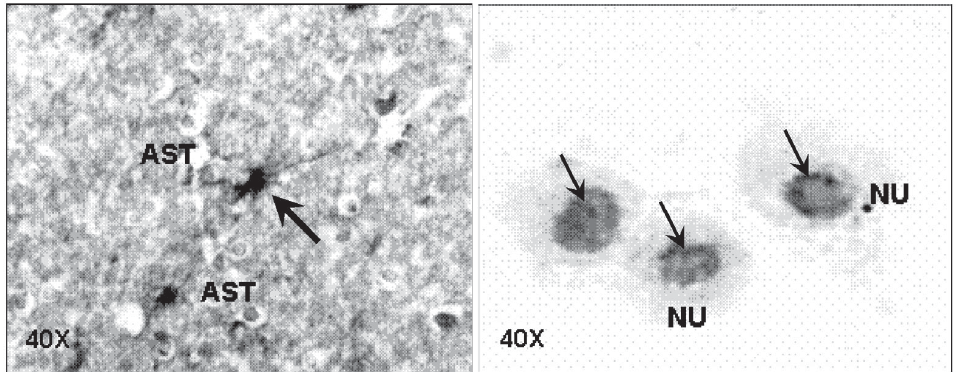
Figure 2. Western blot of proteins obtained from cellular components of the human central nervous system using different monoclonal antibodies (mAb) against human T-lymphotro- pic virus type I proteins. NOR-1 (mAb for gag p24). LT-4 (mAb for tax p40). GIN-7 (mAb for gag p19). WAG-15 (mAb for gag p17). A , Proteins from primary cultures of human astro- cytes. B , Proteins from human fetal brain. RC = Reagent control. About 75 µg total protein was loaded per line.